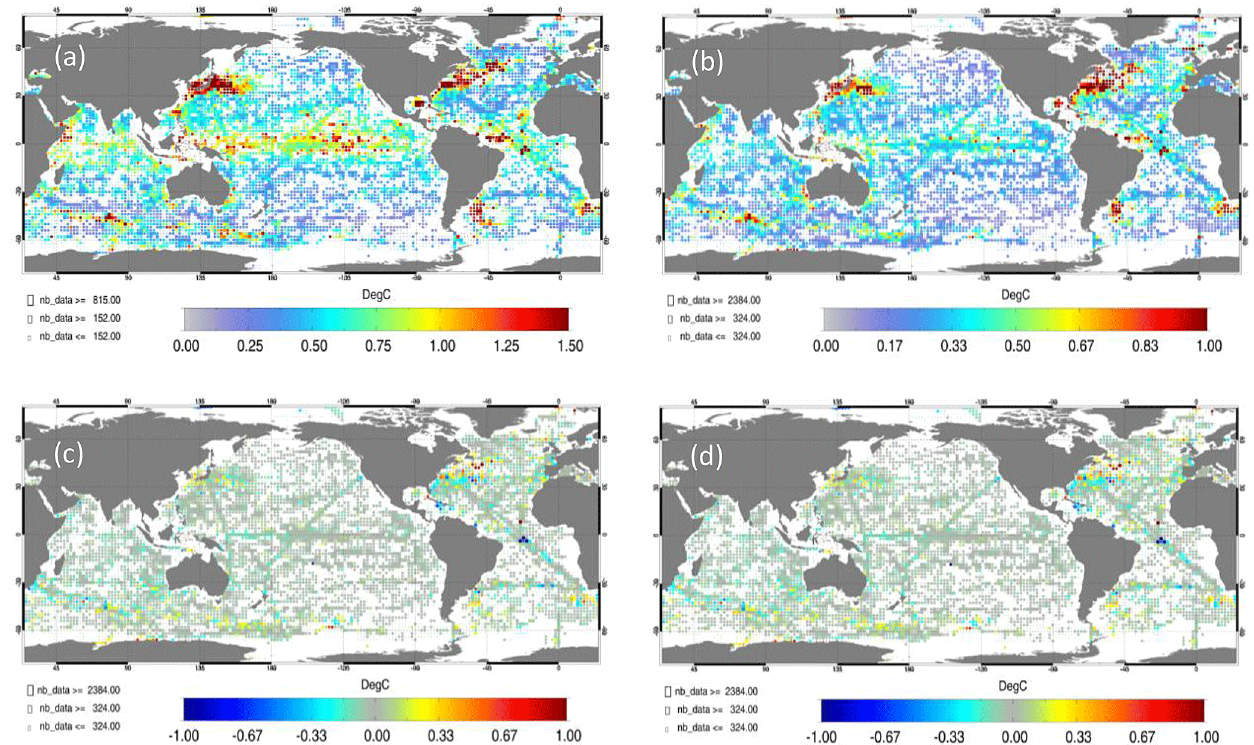
Figure 7. Spatial distribution of the mean and RMS temperature differences between Run-Ref and in situ observations in the 0–300 and 700–2000m layers over the last 6 months of the experiments. (a) shows the RMS temperature differences in the 0–300m layer. (b) shows the RMS temperature differences in the 700–2000m layer. (c) shows the mean temperature differences in the 0–300m layer. (d) shows the mean temperature differences in the 700–2000m layer. The size of the colored boxes is proportional to the number of observations falling into that 2 ◦ × 2 ◦